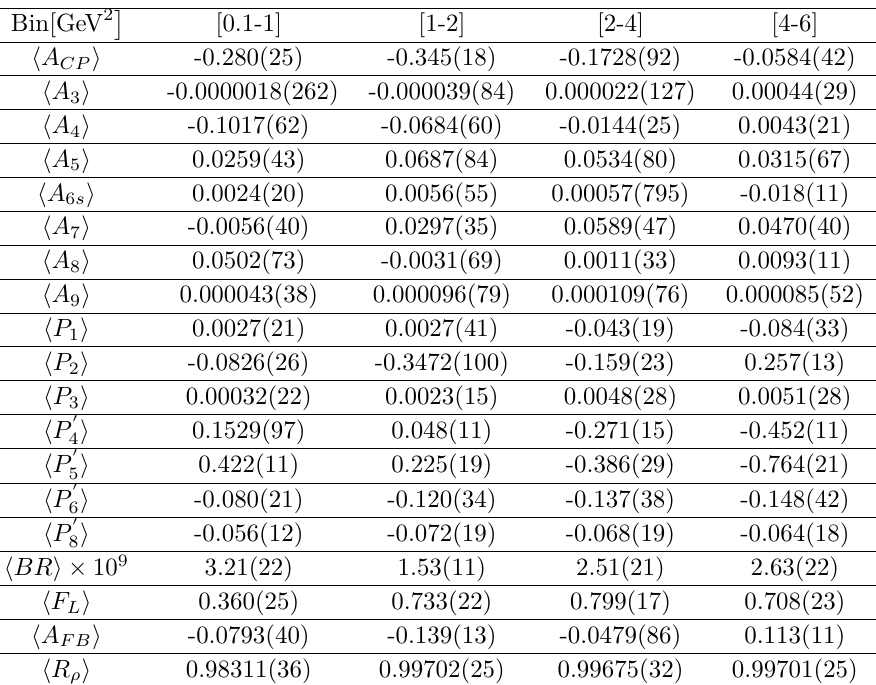
Table 10 . The SM predictions of the CP-averaged and CP-asymmetric observables in B ± → ρ ± ‘‘ decays as measurable both at the LHCb and Belle. These observables are obtained using eq.